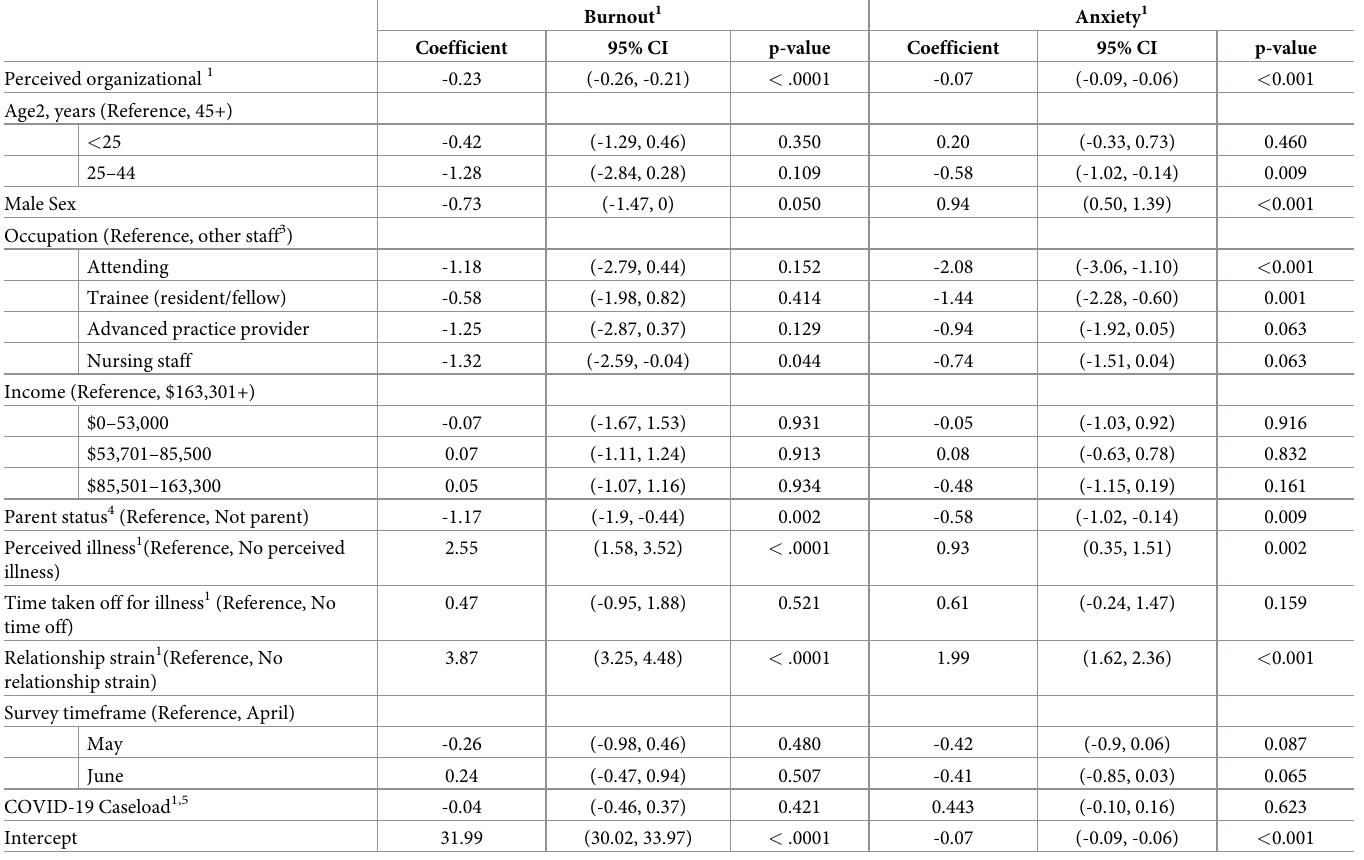
Table 3. Adjusted analysis between variables and outcomes of interest in the primary cohort (N =